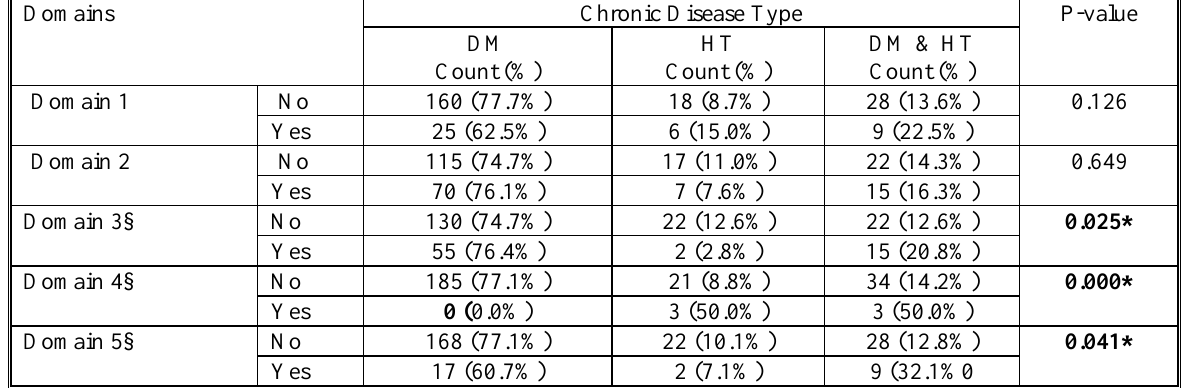
Table 8. The relationships between the patient chronic disease type and the study domains